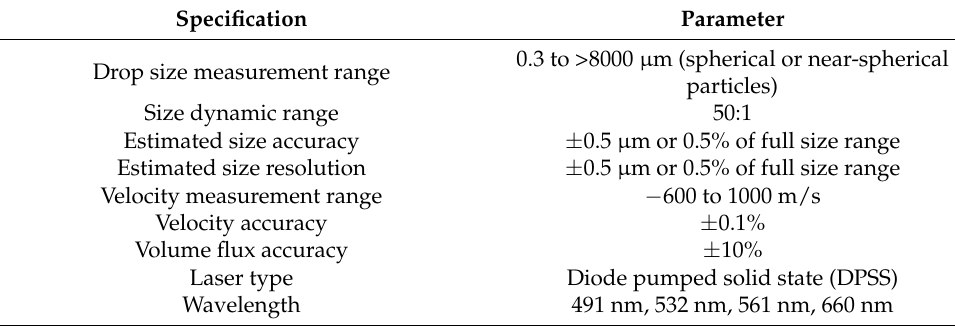
Figure 2. ( a ) Instrumentation used in the experiment. 1. Three-dimensional Positioning Device 2. equipped with AIMS software computer 3. ASA Signal Processor 4. Signal Receiver 5. Signal Transmitter. ( b ) Measurement system of droplet parameters with PDI. 1. Water Storage Tank 2. water Pump 3. Pressure Stabilizing Tank 4. Pressure Regulating Valve 5. Pressure Gauge 6. PDI. Table 2. Phase Doppler Interferometer (PDI) technical